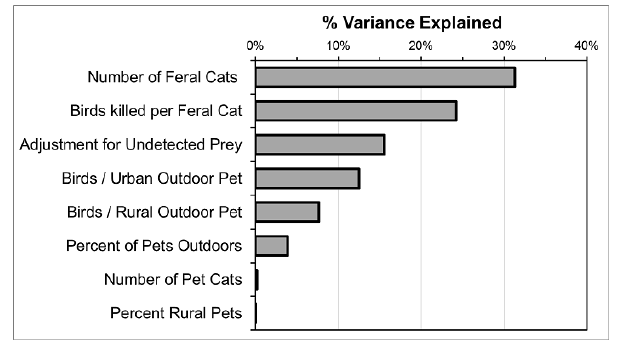
Fig. 3 . Relative sensitivity of total bird kill estimates to the range of values used for individual parameters, as measured by % of variance in kill explained in a regression model (R²).